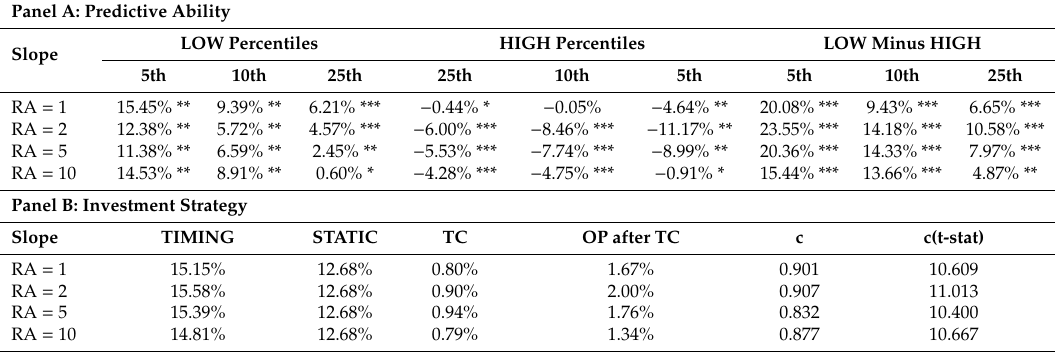
Table A2. Results from using di ff erent risk aversion coe ffi